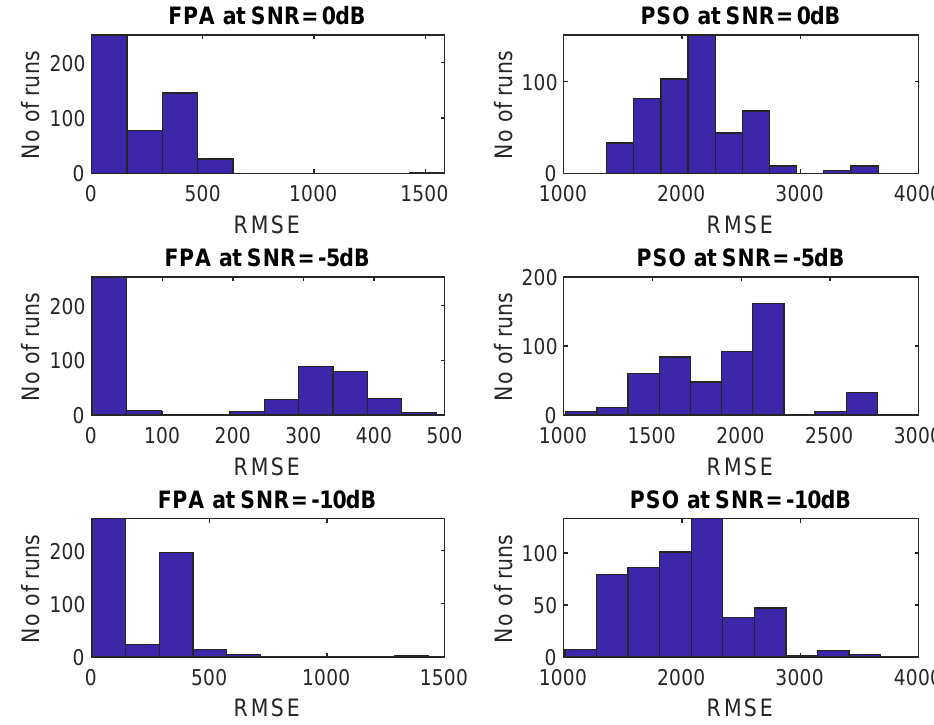
Figure 17. Histogram analysis of RMSE for nine